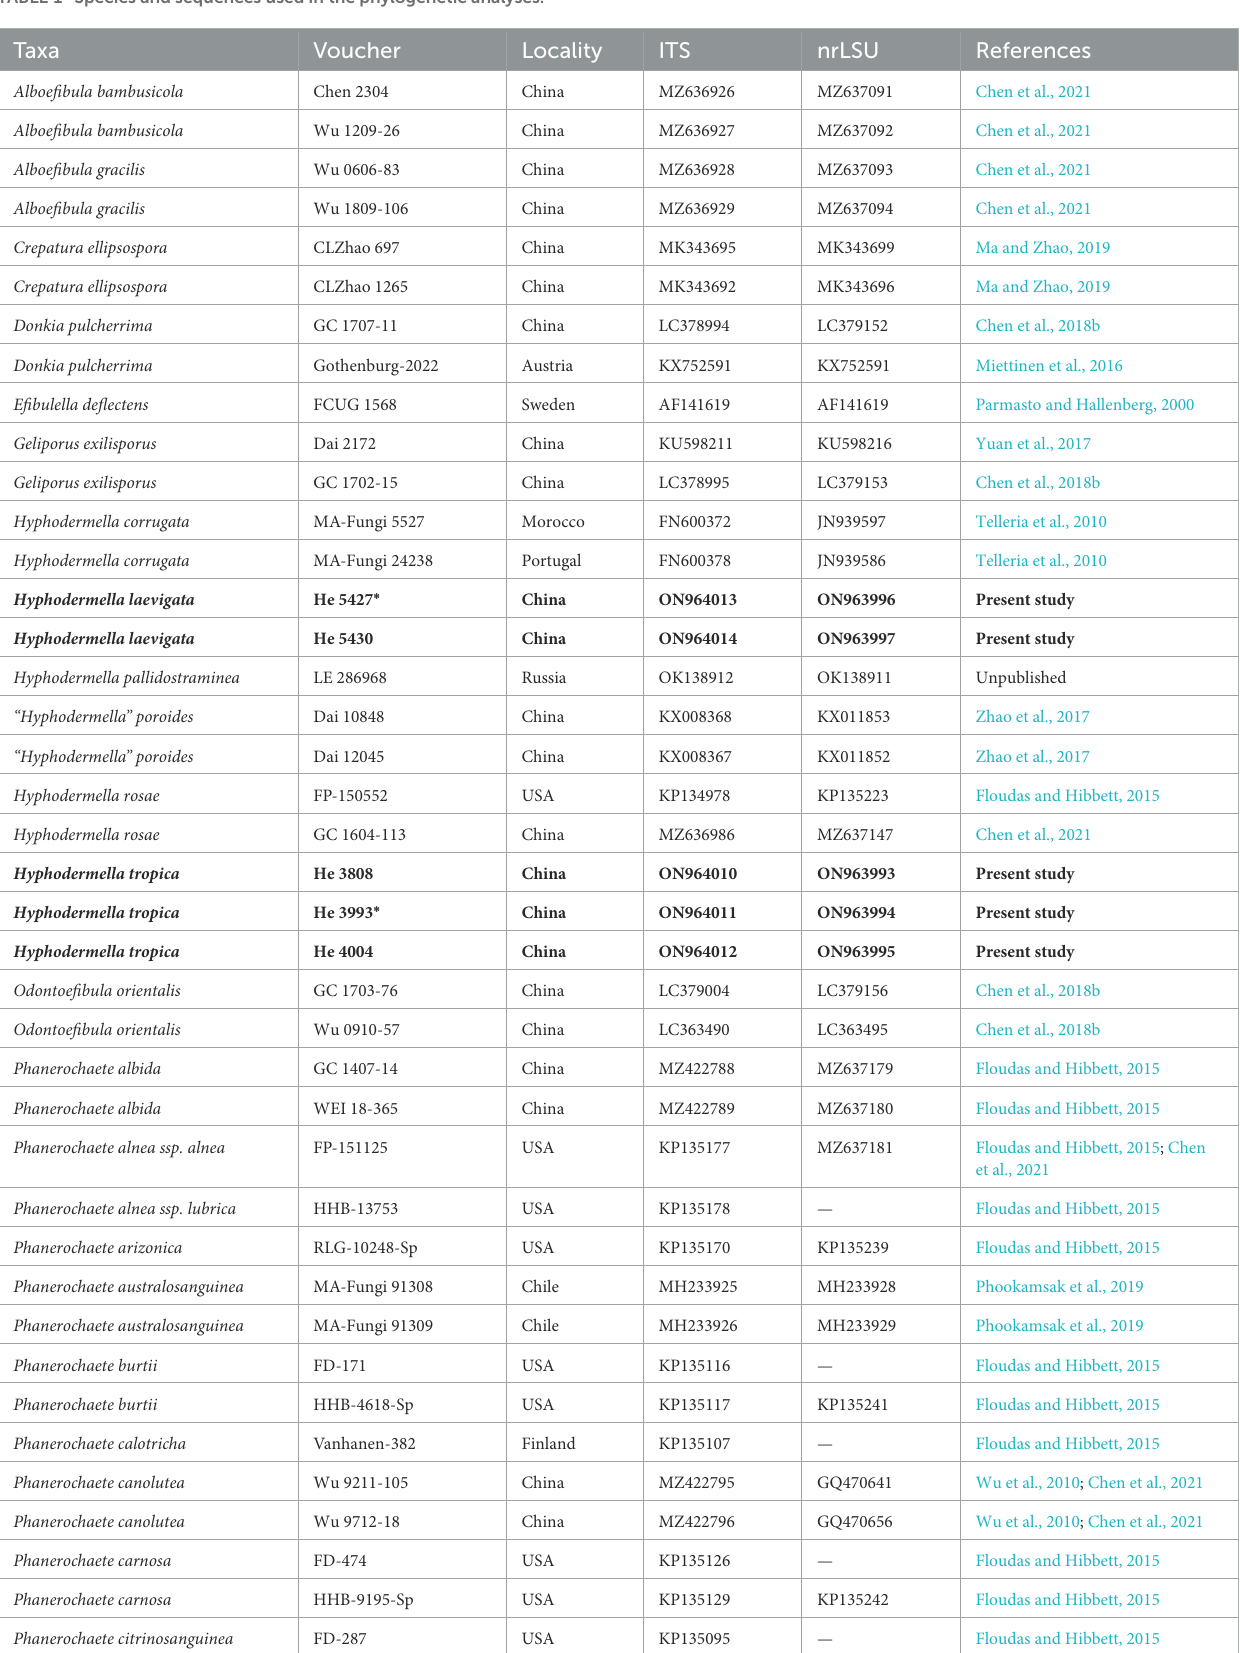
TABLE 1 Species and sequences used in the phylogenetic